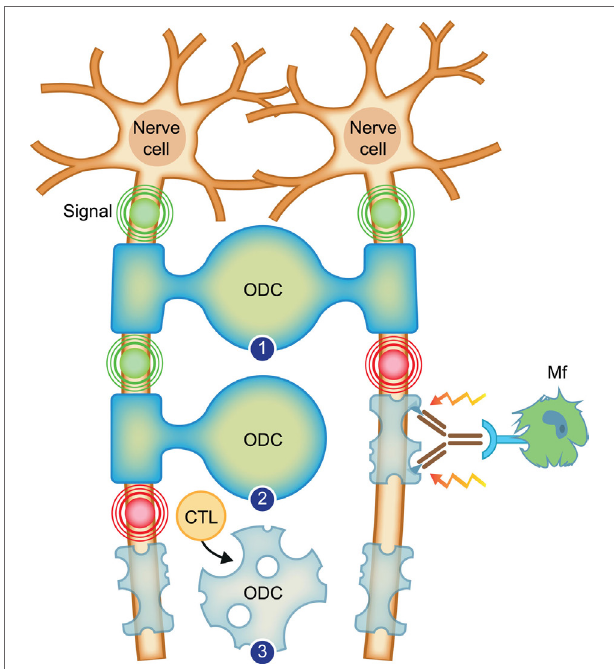
FiGURe 2 | Working concept for the transition of relapsing–remitting multiple sclerosis (RRMS) to secondary progressive multiple sclerosis. Depicted are two neurons, which send electrical signals (indicated with concentric circles) along axons to organs on which they project. The axons are enwrapped with protective myelin sheaths, which are produced and repaired by oligodendrocytes (ODC). (1) Healthy myelinated axons. (2) In RRMS , the myelin sheath, in this case of the right axon, is attacked by binding of an antibody, which recruits inflammatory cells, such as the depicted macrophage (Mf). The Mf releases myelinotoxic factors that cause demyelination. New myelin formation (remyelination) is possible as the oligodendrocyte is spared. (3) In progressive multiple sclerosis , the myelin-forming oligodendrocyte is killed by cytotoxic T lymphocytes (CTL). Conceptually, this leads to permanent loss of